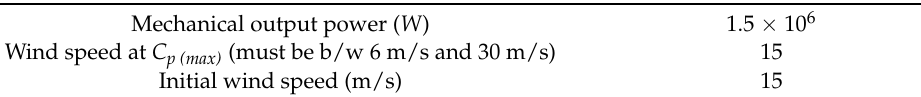
Table A1. Turbine Data.